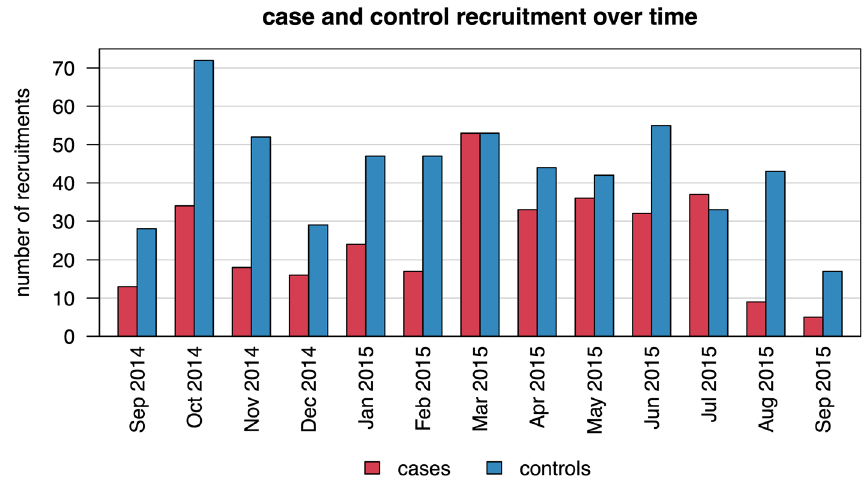
Figure 1. Recruitment of cases and controls during the study period.